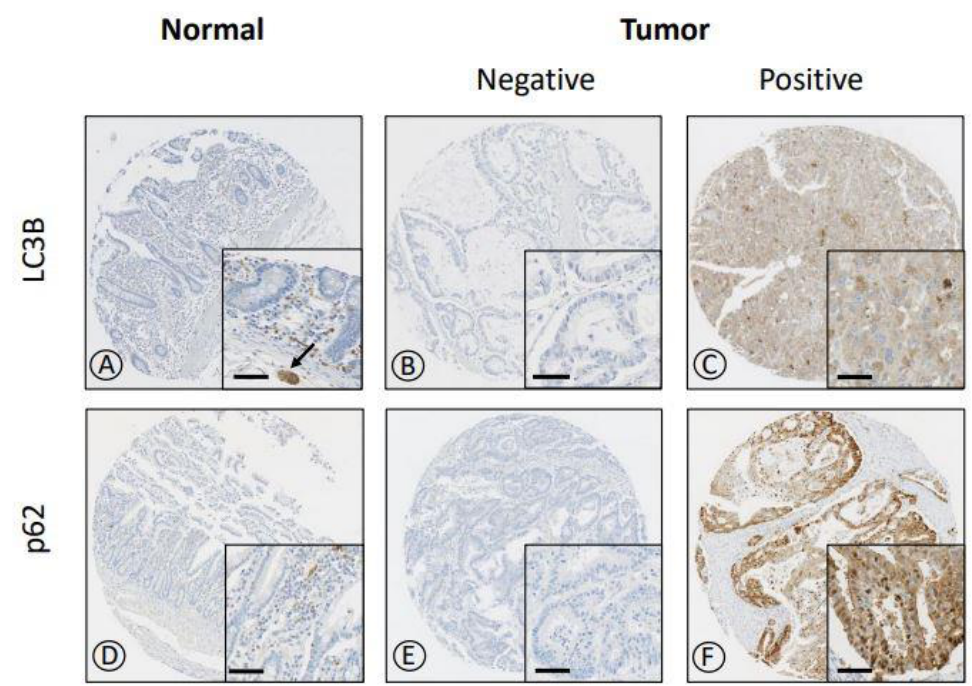
Figure 2. Representative immunohistochemical staining for LC3B and p62 expression in SIAC and normal mucosal tissue. Normal small intestinal epithelial cells did not express LC3B and p62. Some stromal mononuclear cells were weakly reactive for LC3B and p62 and showed punctate or linear cytoplasmic staining (( A , D ), inset). Ganglion cells showed positive staining for LC3B and thus served as an internal staining control (black arrow, (A), inset). LC3B staining showed a cytoplasmic punctate pattern ( C ), while p62 showed cytoplasmic punctate pattern with/without nuclear expression ( F ). The middle columns show representative negative stainings ( B , E ) (original magnification, × 8; inset, × 40; scale bar, 50 µ m).